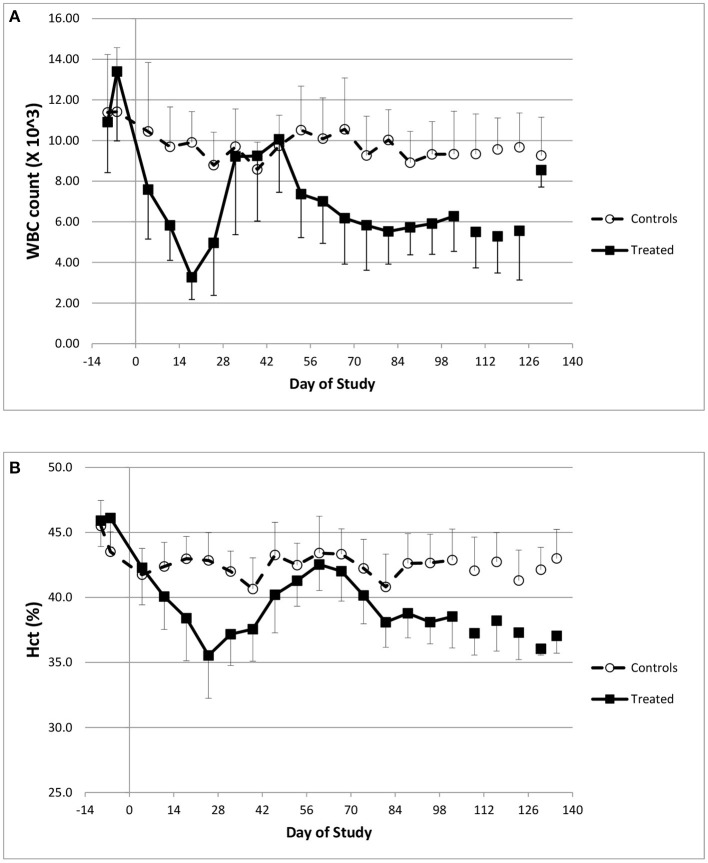
Hematology changes. Changes in white blood cell counts (A) and Hematocrit (B) over the course of the study.